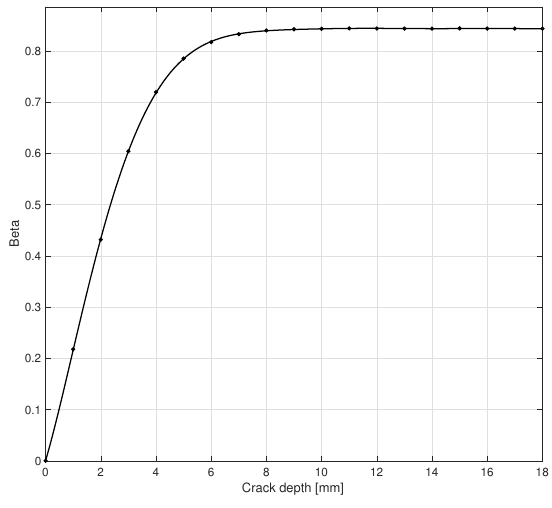
Figure 3. β -tool curve for the experiment.